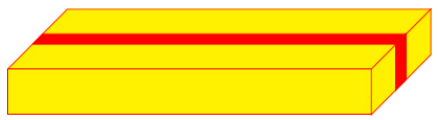
Figure 8. Overlap of the two concurrent depositions (overlapping volume marked with red).